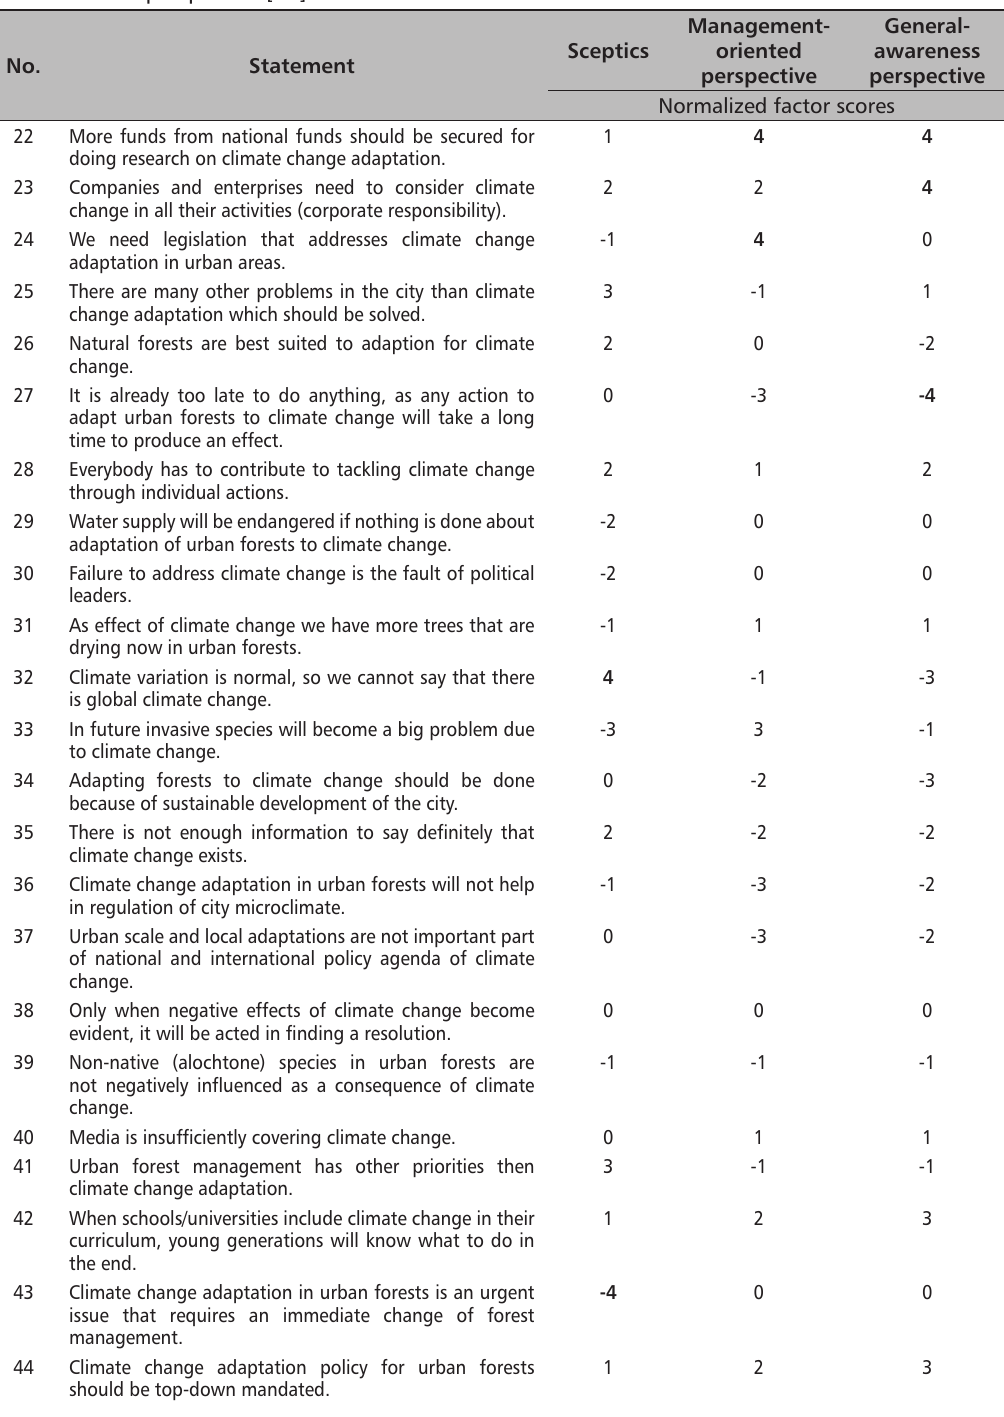
TABLE 2. List of statements used in Q-methodology with normalized factor scores for each statement and perspective [29] - continuation No. Statement